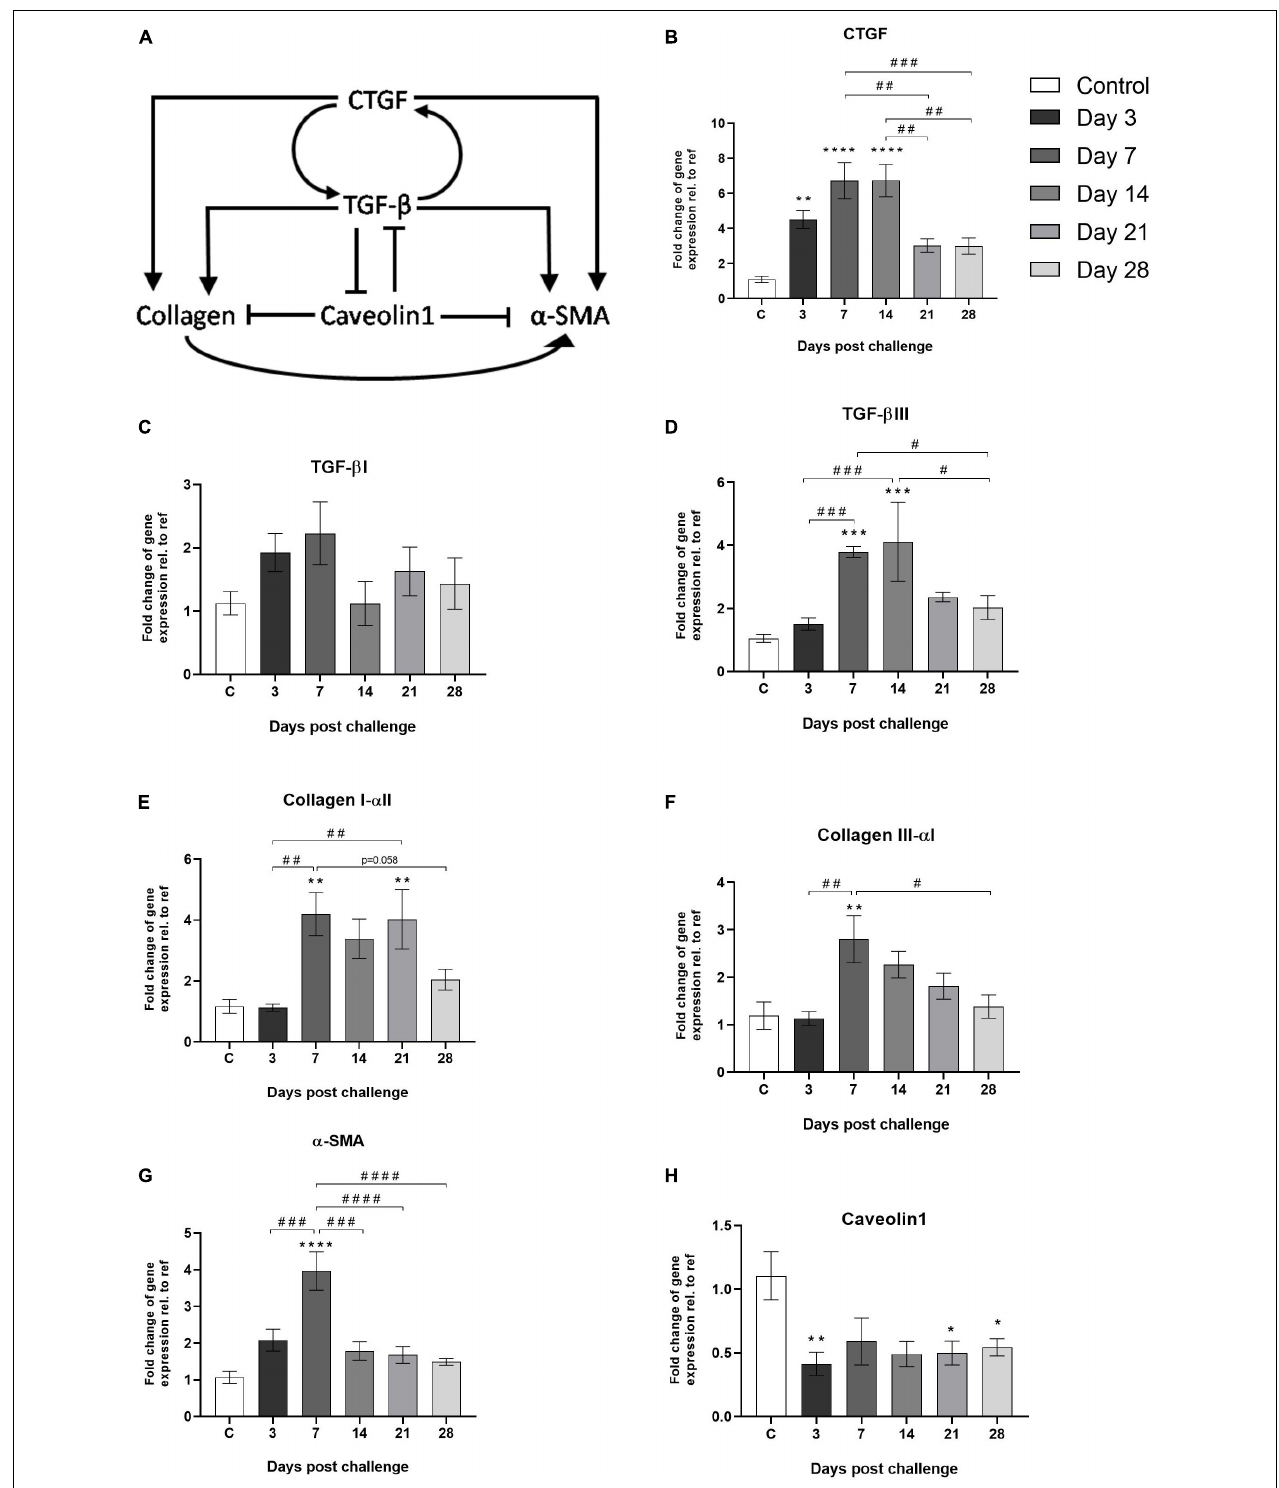
FIGURE 8 | Gene expression of markers known to be involved in the TFG- β /CTGF-axis. (A) Schematic image of the TGF- β /CTGF-axis involving markers known to be part of the fibrosis process in lung tissue (Wang et al., 2006; Lipson et al., 2012; Lin et al., 2013). Gene expression of (B) CTGF, (C) TGF- β I, (D) TGF- β III, (E) Collagen I- α ll and (F) Collagen llI- α l, (G) α -SMA, and (H) Caveolin1, are presented as mean ± standard error of the mean (SEM). All samples from the bleomycin group are related to the mean value of all control samples and normalized to the geometric mean of five reference genes. Each presented group/time point contains n = 4 – 8. Significance is indicated by ** when p < 0.01; p < 0.001 by *** and p < 0.0001 by ****, when comparing bleomycin towards the saline control. The comparison of various time points between bleomycin-challenged groups is expressed as # when p < 0.05; ## when p < 0.01; ### when p < 0.001 and #### when p < 0.0001.